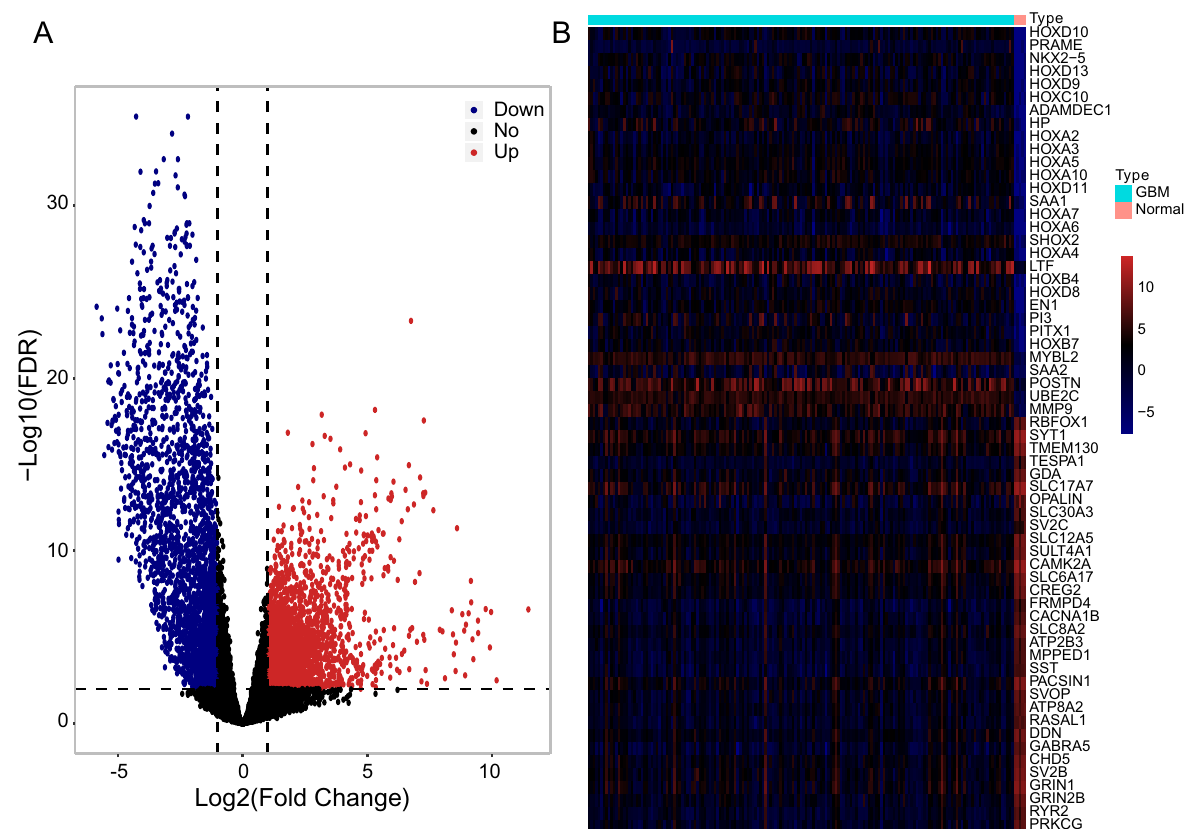
Figure 1. Differential expression of protein-coding genes in patients with glioblastoma. ( A ) Volcanic maps for differentially expressed genes. The x-axis specifies the log2 value of fold change (FC) and the y-axis specifies the negative log10 value of FDR (Adjusted P-value). Black dotted vertical and horizontal lines reflect the filtering criteria (FC = ± 2 and FDR = 0.01). Red dots represent 2413 significantly upregulated genes. Blue dots represent 2435 significantly downregulated genes. Black dots represent nondifferentially expressed genes. ( B ) Heat maps of the top 30 most upregulated and downregulated genes in normal and GBM